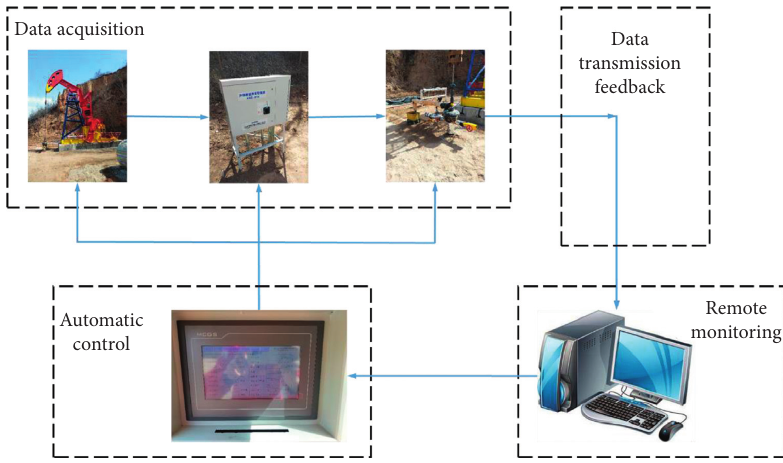
Figure 5: Schematic diagram of the intelligent production management system. Table 3: Production data of horizontal wells in the Libi